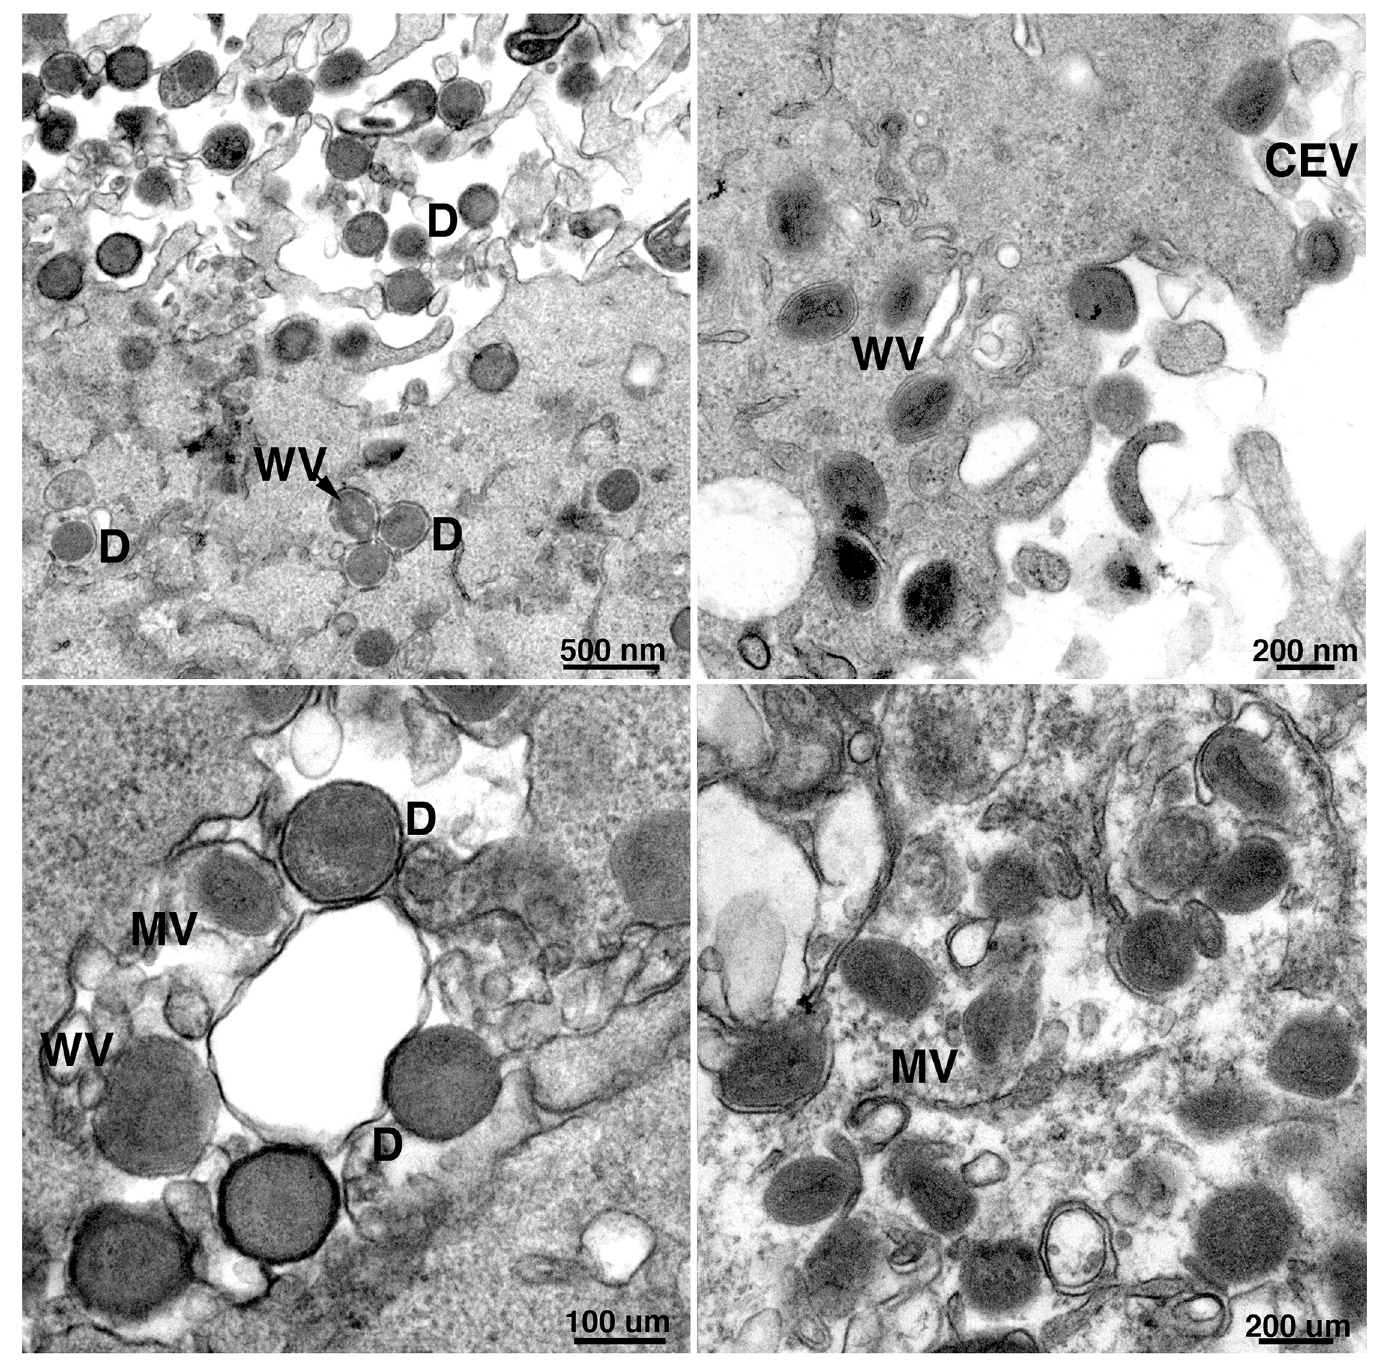
Fig 6. Transmission electron microscopy of cells infected with MVA. A549 cells (upper and lower left panels) and A549 ZAP-KO cells (upper and lower right panels) were infected with 10 PFU/cell of MVA. After 20 h, cells were fixed, sectioned and analyzed by transmission electron microscopy. Symbols: D, dense particle; MV, mature virion; WV, wrapped virion; CEV, cell-associated enveloped virion. Magnification factors shown below each